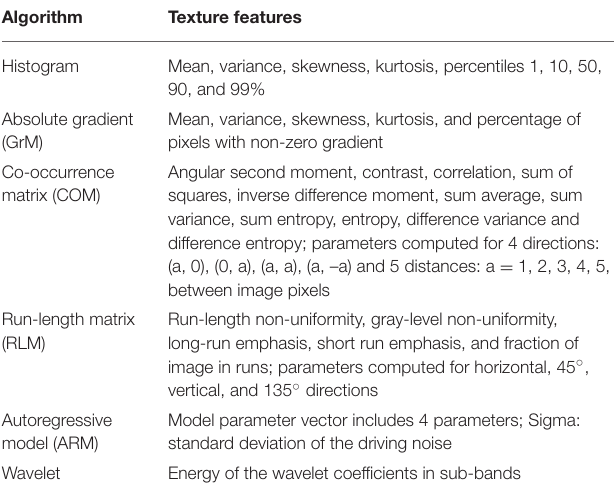
TABLE 1 | Texture features used